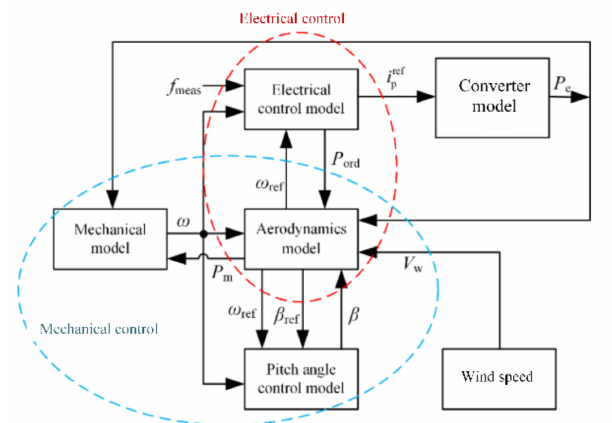
Figure 1. A general DFIG model contains five sub-models: a converter, an electrical control, aerodynamics, mechanical, and wind speed.